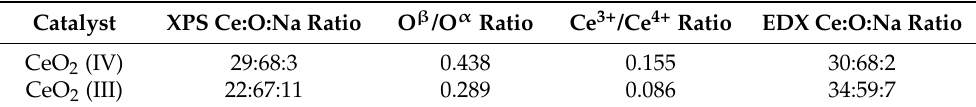
Figure 9. X-ray photoelectron spectra of Ce 3d region for ( a ) CeO 2 (IV) and ( b ) CeO 2 (III) catalysts, where fitted peaks refer to Ce 3+ (blue) and Ce 4+ (red) states. Table 3. X-ray photoelectron spectroscopy and energy dispersive X-ray analysis derived surface elemental composition for the CeO 2 catalysts.